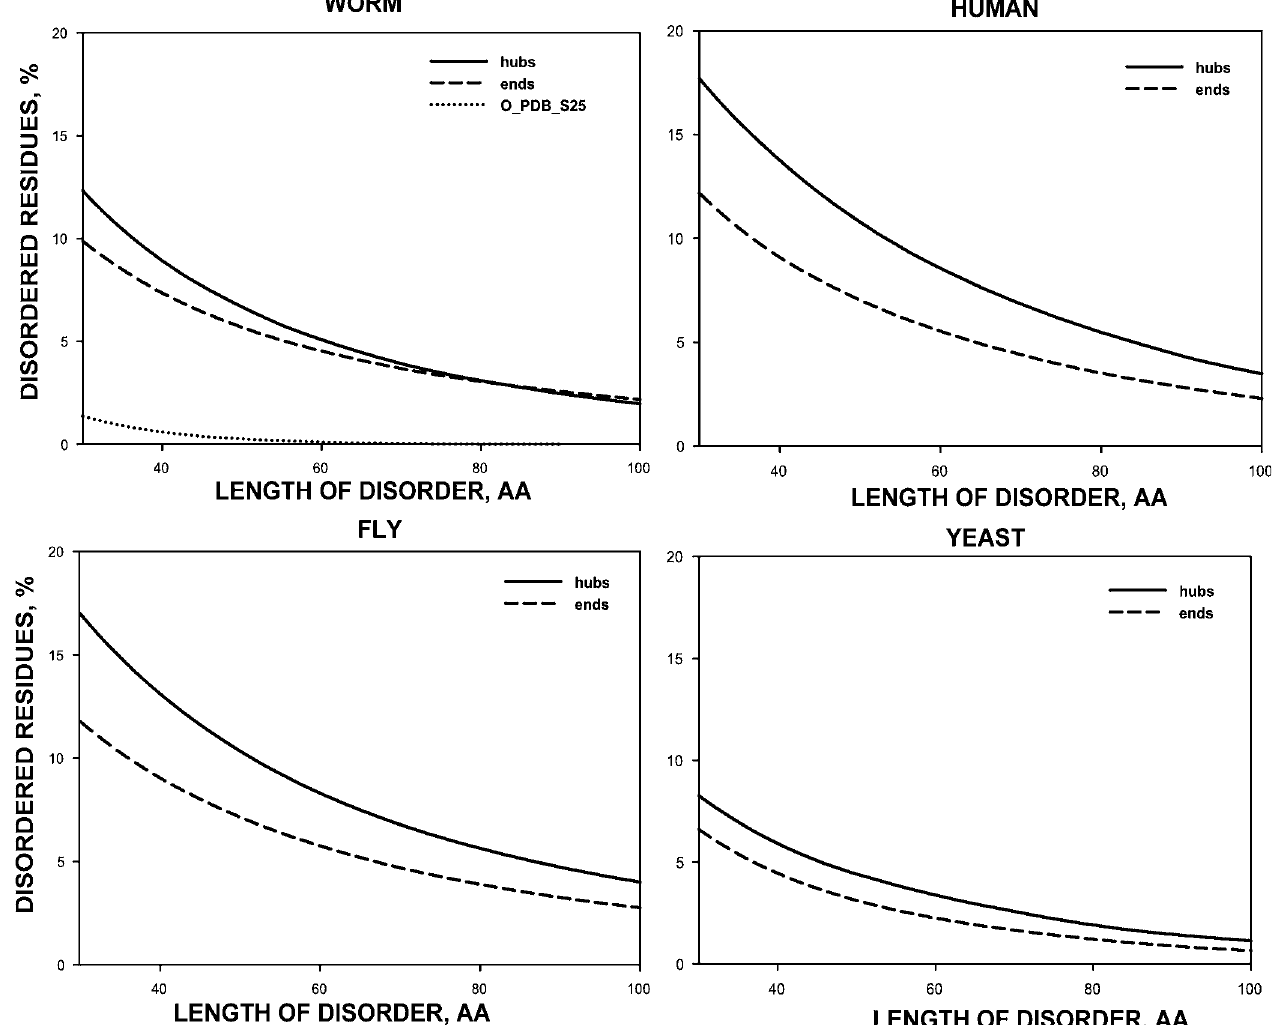
Figure 2. The Percentages of Residues Predicted to Be Disordered within Segments of Length (cid:1) the Value on the x -Axis DOI: